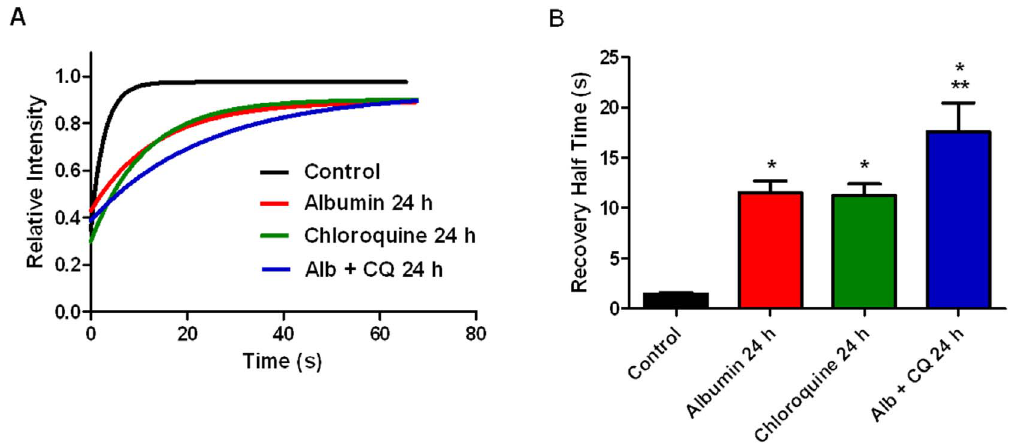
Figure 4. Prolonged exposure of podocytes to albumin and chloroquine decreased lysosome activity. Lysosome activity in living podocytes was determined by fluorescence recovery after photobleaching (FRAP). Using confocal microscopy, regions of interest containing individual lysosomes were isolated and photobleached. Exponential curves of the recovery of fluorescence intensity, which represents cathepsin B activity, were obtained. A ) Representative recovery curves for control (black), 24 h albumin exposed (red), 24 h chloroquine exposed (green), and podocytes exposed to both albumin and chloroquine for 24 h (blue). B ) Bar graph of recovery half times (mean + / 2 SEM), which are inversely related to cathepsin B activity. Cathepsin B activity was decreased in 24 h chloroquine (n=10) and 24 h albumin (n=10) exposed podocytes compared to control (n=10), *p , 0.05. Cathepsin B activity decreased further in podocytes exposed to both albumin and chloroquine for 24 h (n=10) compared to each exposure alone, **p ,